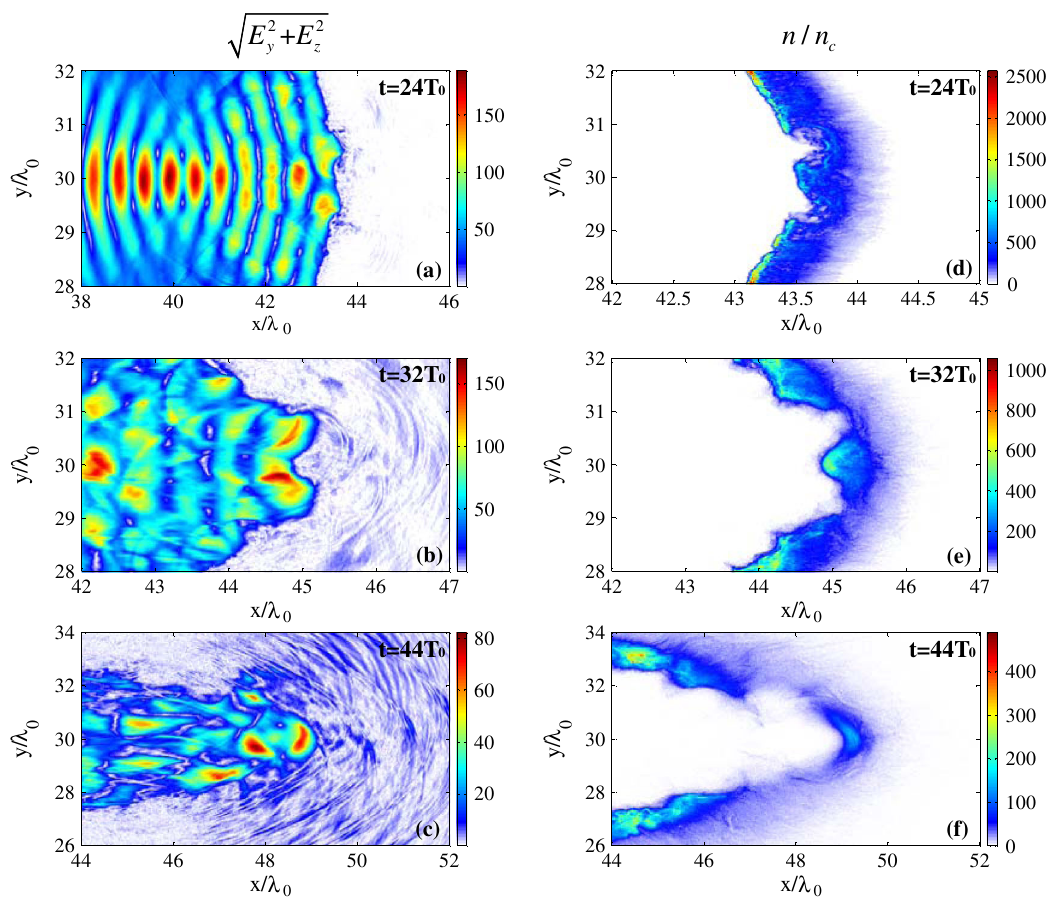
ffiffiffiffiffiffiffiffiffiffiffiffiffiffiffiffiffiffi q E 2 þ E 2 at different y z